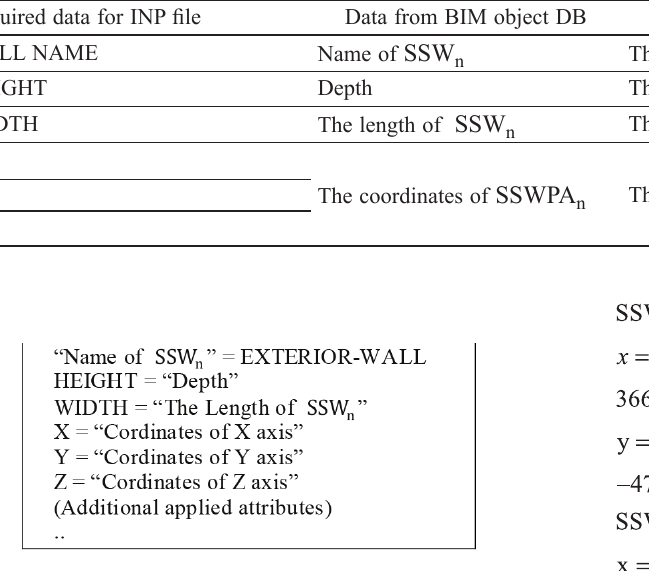
Fig. 9. Template of INP